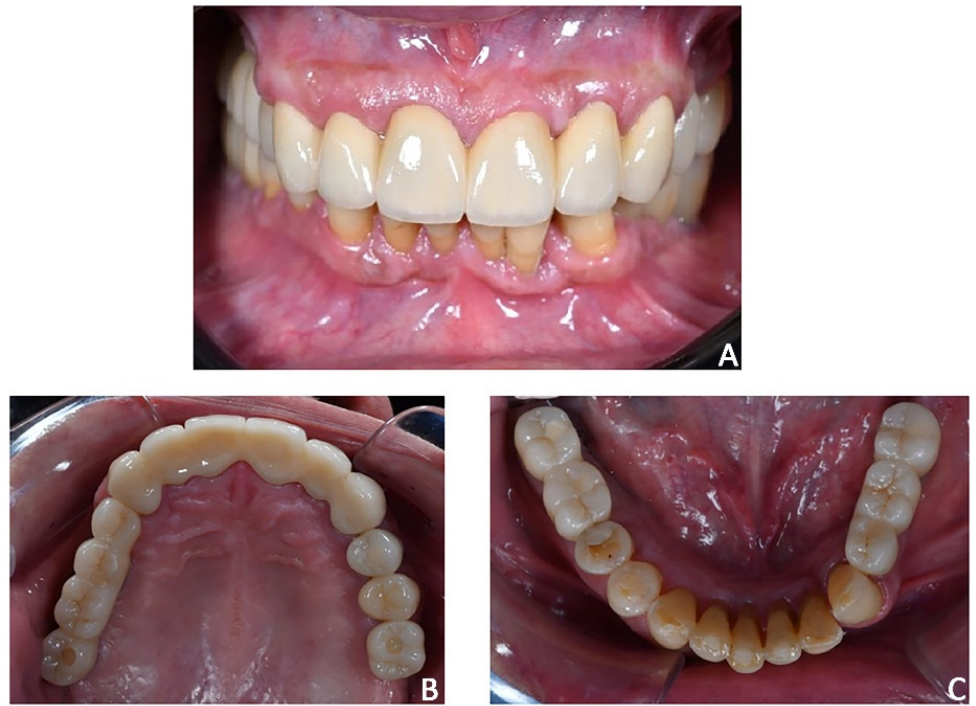
Figure 20. Case 3. The case was finalized by replicating the information functional characteristics of the provisional crowns in the final definitive prosthesis. ( A ) Intra-oral frontal view; ( B ) occlusal upper view; ( C ) occlusal lower view.